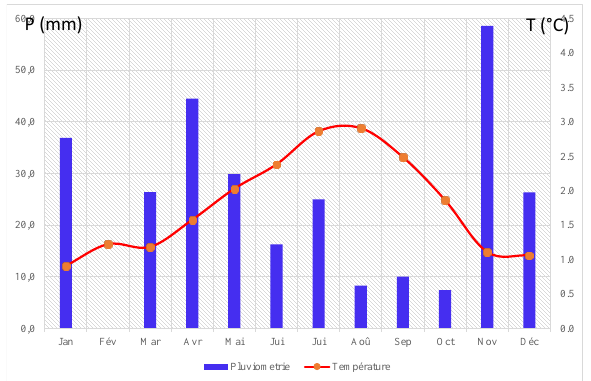
Figure 2 . Rainfall across temperature variation in the season 2020-2021.